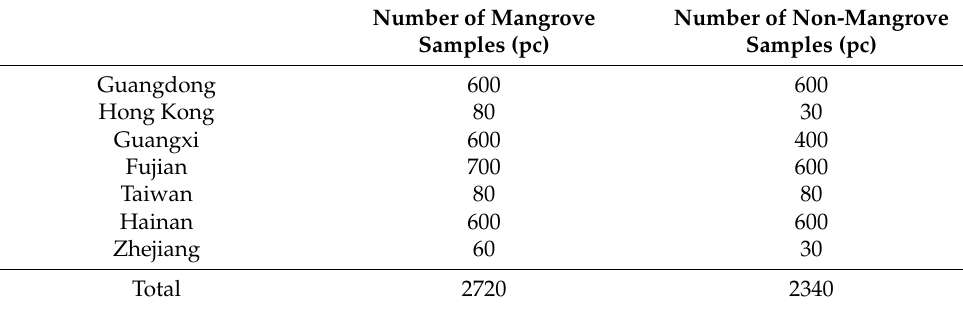
Table 1. Number of mangrove and non-mangrove samples by province.